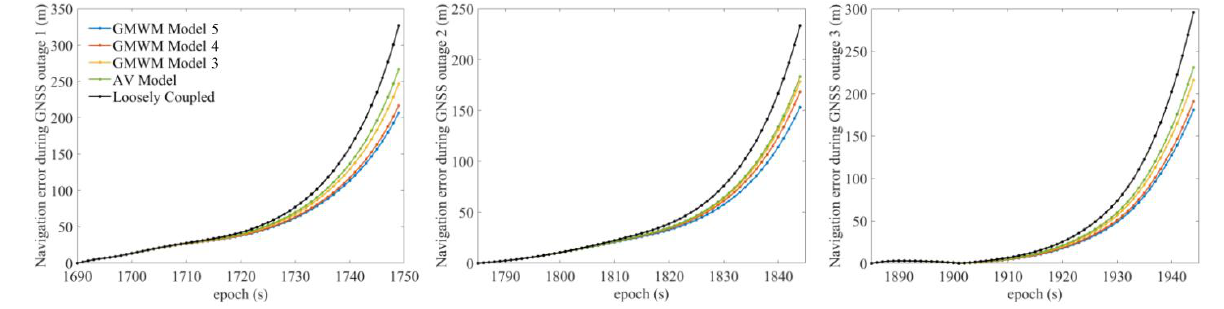
Figure 5. GMWM log – log plot of the three-axis gyroscope ( left column ) and AV log – log plot of the three-axis gyroscope ( right column ). The red dashed lines are auxiliary lines to help identify linear regions.